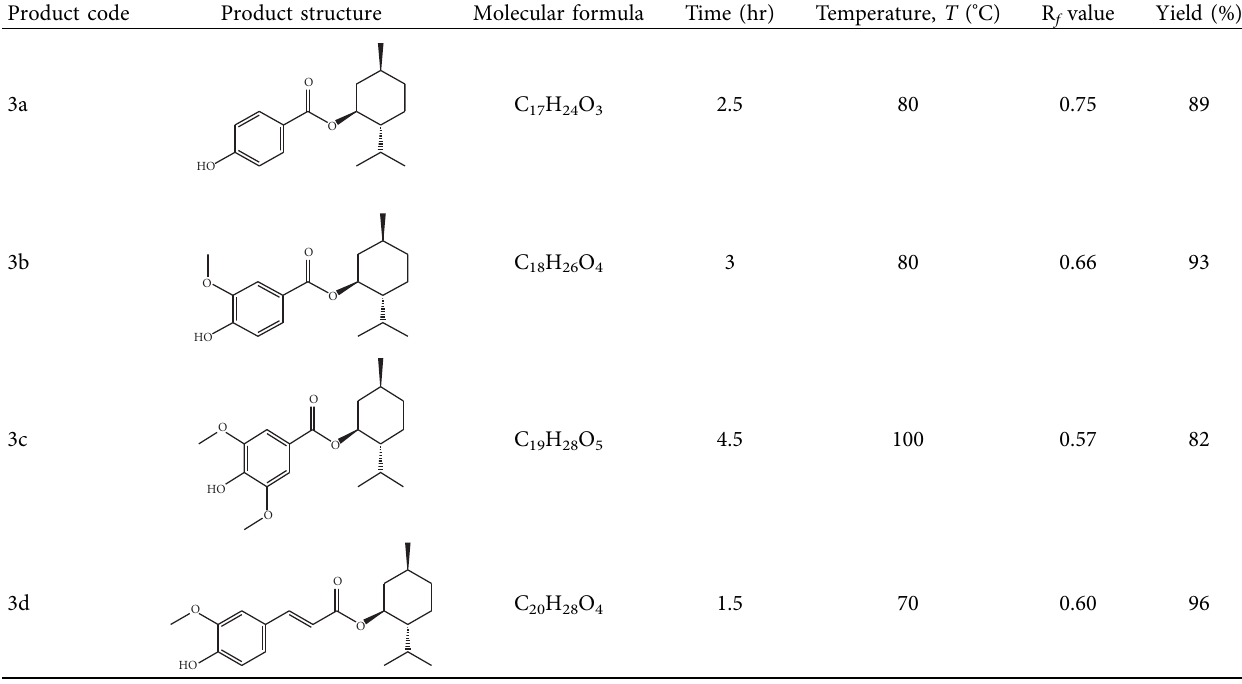
Table 6: Summary of physical data and reaction conditions of nonpolar aglycones